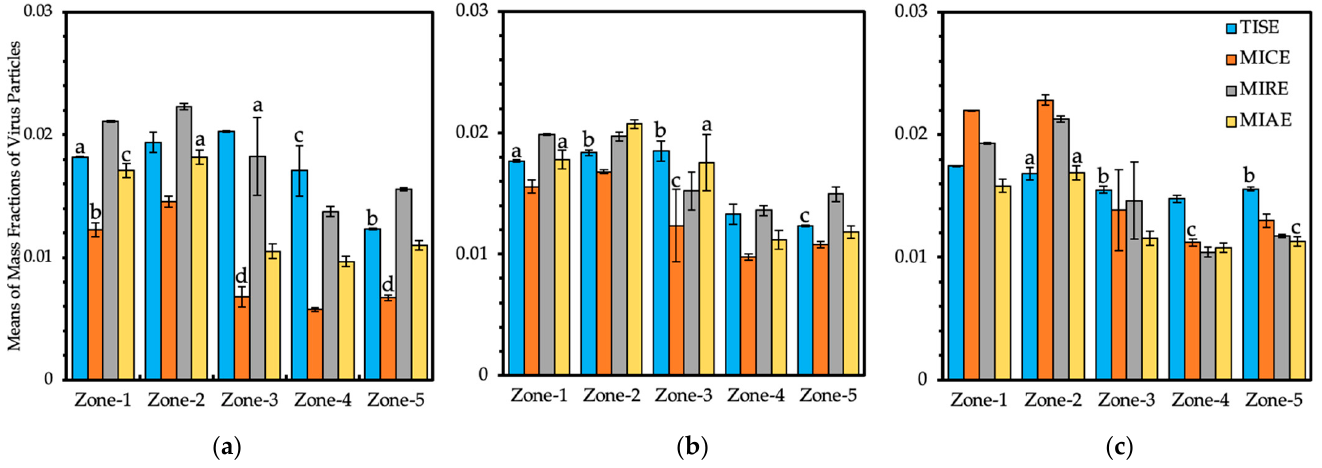
Figure 8. Mass fraction means of virus particles from five bird-occupied zones at three cross-sectional planes, ( a ) CP-I, ( b ) CP-N, and ( c ) CP-F, in four models: TISE, MICE, MIRE, and MIAE. Annotations with the same letters indicate NO statistical significances were found for the differences between the comparisons at a 95% family-wise confidence level. Error bars indicate standard deviations of simulation data points in each zone.